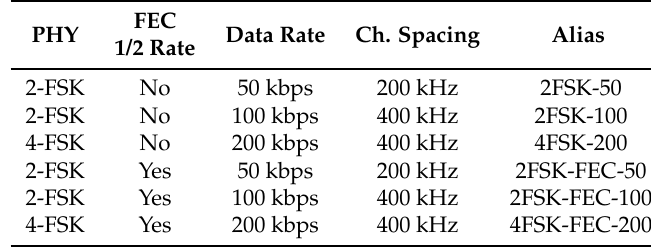
Table 1. Radio settings using FSK modulation. The values of these parameters are defined in the standard [22]. Data rate values consider the amount of bits per second leaving the radio. In the case where FEC is used, 1 bit of information is encoded in 2 bits leaving the radio, therefore the information rate reduces to half. Channel spacing is the separation between the center of two adjacent channels. The “Alias” column provides an identifier to each group of parameters.